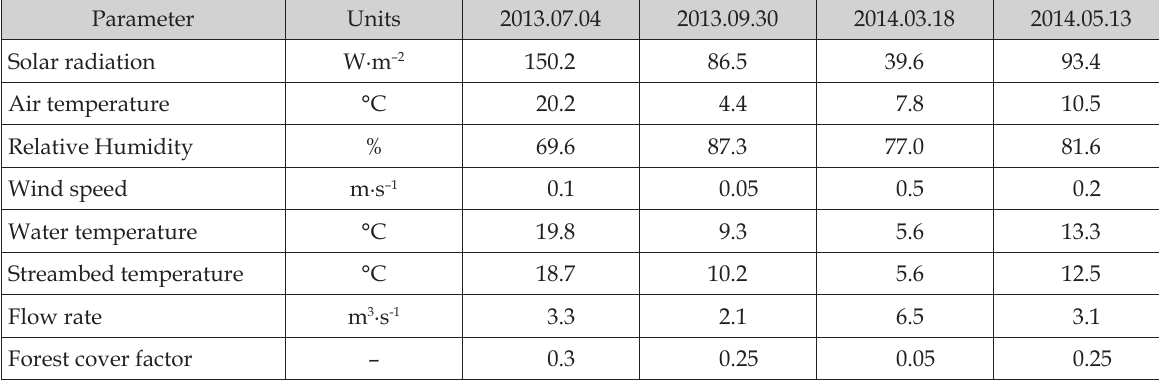
Table 2. Average values of selected meteorological and hydrological parameters